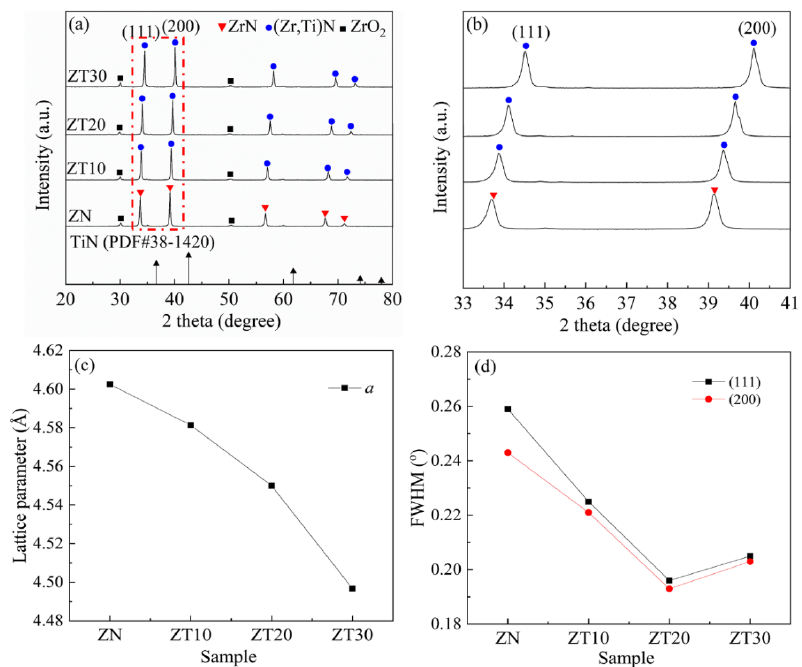
Figure 2. ( a ) XRD patterns of the sintered samples: ( b ) high-angle area expanded pattern; ( c ) lattice parameter a ; ( d ) FWHM of (111) and (200) planes. Materials 2022 , 15 , 7866